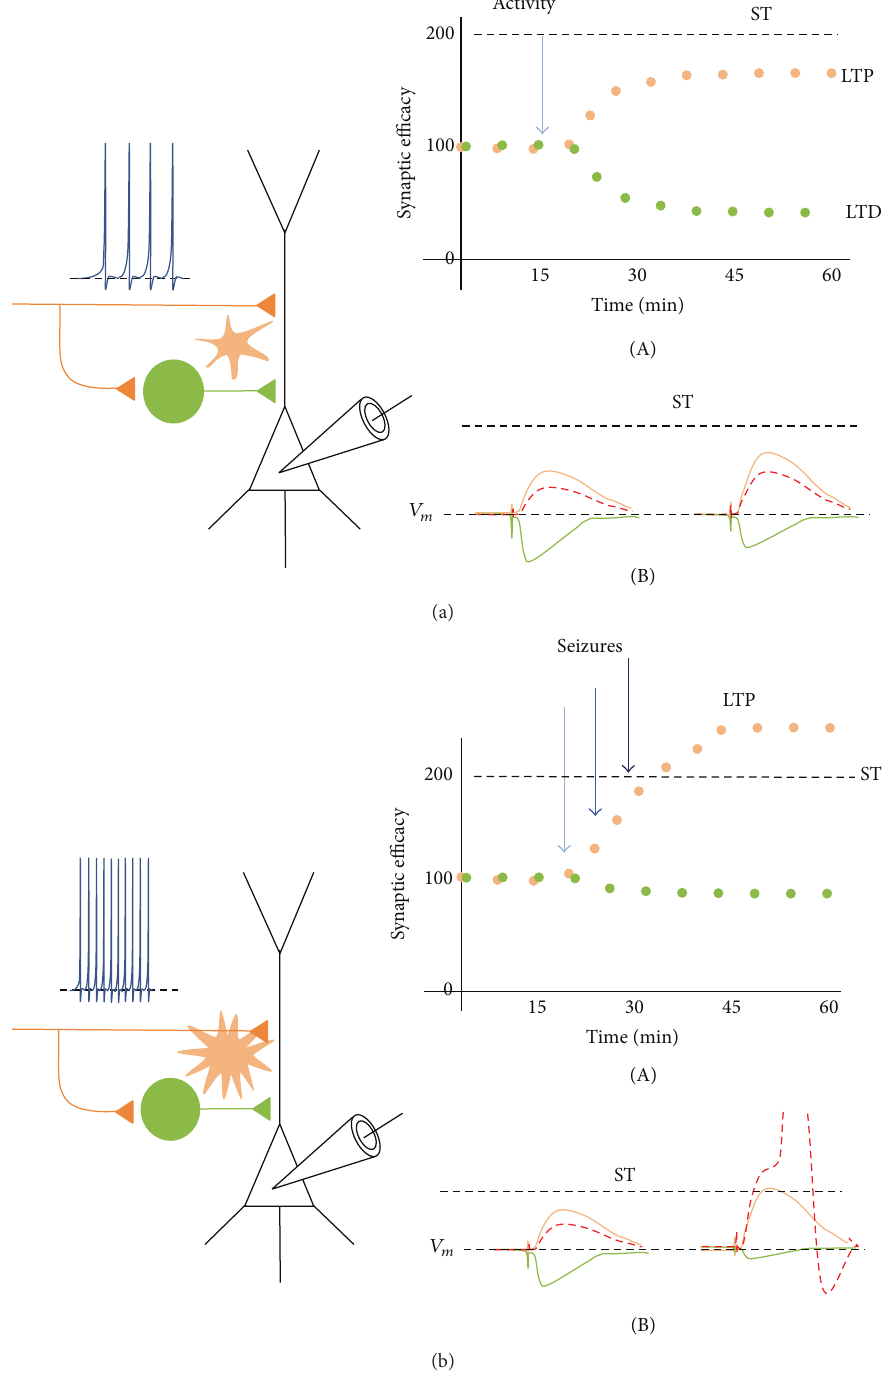
Figure 1: Glutamatergic and GABAergic long-term plasticity and tripartite neuronal-astroglial network in normal and epileptic brain. (a) During physiological neuronal activity, coincidence between postsynaptic depolarization and glutamatergic (orange) and GABAergic interneuron (green) simultaneously activated induces increase of synaptic efficacy (i.e., mean amplitude of postsynaptic response) in both glutamatergic [CB1] synapses (LTP) at the same time of a decrease of efficacy of GABAergic transmission (LTD; A). (B) By GABAergic and glutamatergic input integration, the net increase in membrane potential falls below the seizure threshold (ST). (b) During epileptiform neuronal activity, astroglial hyperexcitation through GABA A Rs, GluRs, and/or eCBsRs activation, which increases the intracellular Ca 2+ release of astroglial glutamate, increasing the excitatory neurotransmission while inhibitory transmission remains unchanged (A). (B) In this condition, glutamatergic/GABAergic rate results in an excitatory imbalance, exceeding the seizure